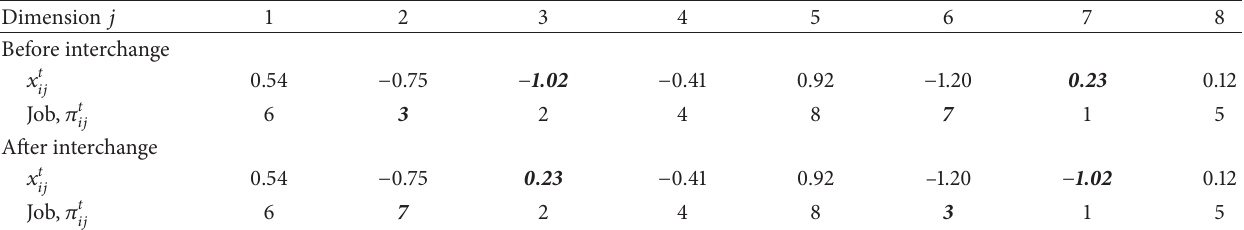
Table 2: Interchange move on the job permutation and the corresponding position value